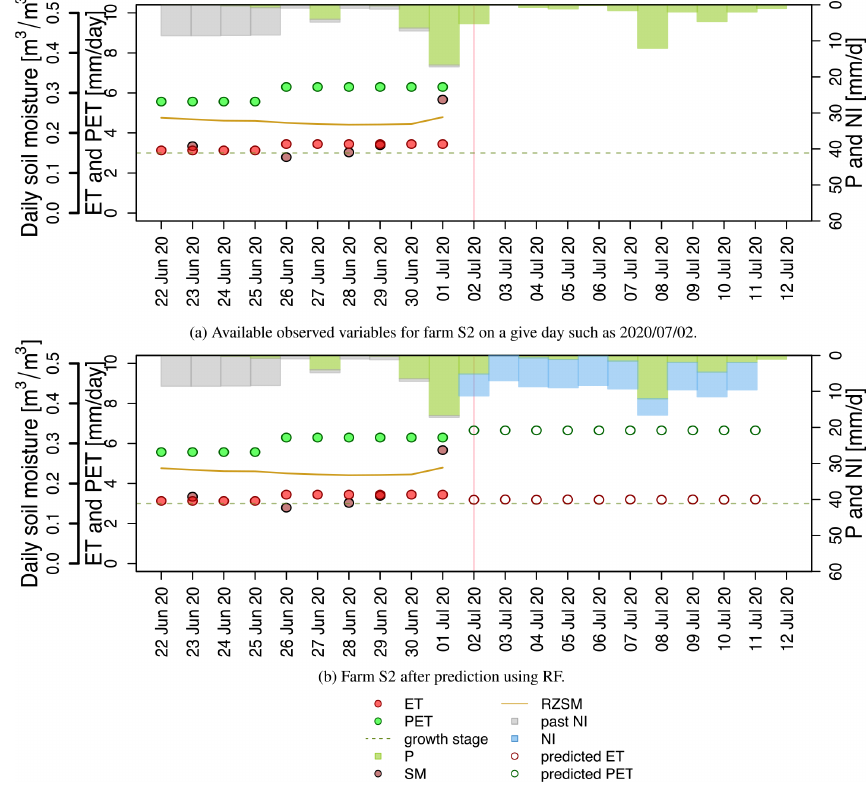
Figure 7. Farm S2 before and after prediction relative to the date 2 July 2020. Over the next 10d, the total predicted PET is 67mm, total predicted ET is 32mm, total P is 30mm, and NI is 71mm.